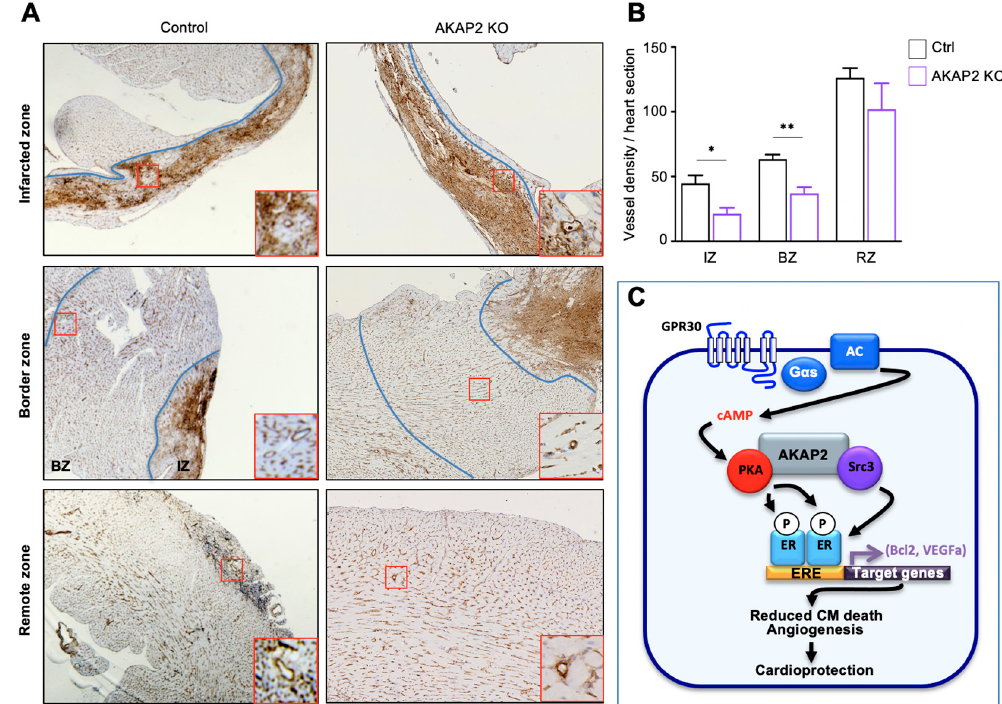
Figure 8. AKAP2 knockout in adult cardiomyocytes reduces vessel number in infarcted and border zones. ( A ) Control (Ctrl) or cardiomyocyte-specific AKAP2 KO mice underwent sham operation or LAD ligation. Two weeks after surgery, hearts were harvested and included in paraffin. Deparaffinized-heart sections were stained for lectin. ( B ) For each heart, the number of vessels was quantified on 3 or 4 heart sections, using the ImageJ software. Vessel density was reported for infarcted (IZ), border (BZ) and remote zones (RZs). Results are presented as the mean ± SEM. Ctrl-MI n = 7, AKAP2 KO-MI n = 4; * p < 0,05; ** p < 0,01. ( C ) AKAP2 assembles a signaling complex in cardiomyocytes, which coordinates the ER α activating activity of PKA and Src3. The AKAP2-anchored pool of PKA becomes activated in infarcted hearts and promotes the phosphorylation of ER α on Ser305. ER α phosphorylation in conjunction with Src3, enhances the transcriptional activity of ER α , which increases the transcription of anti-apoptotic and pro-angiogenic genes, such as Bcl2 and VEGFa. Consequently, apoptosis is reduced, and the number of blood vessels increased in the infarcted region, which protects the heart during ischemic stress.